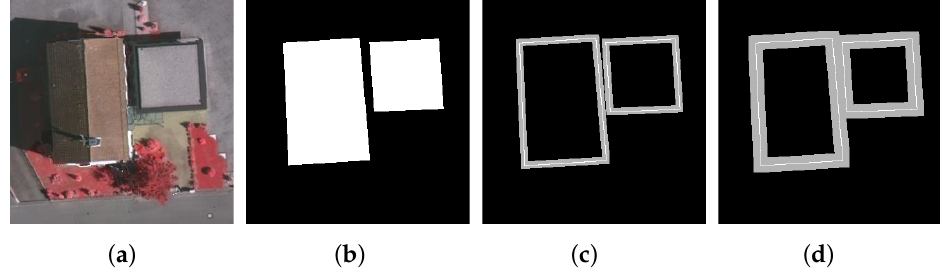
Figure 4. Evaluation of boundary accuracy within trimap regions. ( a ) Test image; ( b ) annotation; ( c ) the trimap with a width of 5 pixels. ( d ) the trimap with a width of 10 pixels. The trimap regions for conducting accuracy evaluation are colored gray and were generated by taking 5 and 10 pixel bands surrounding the object boundaries, respectively.